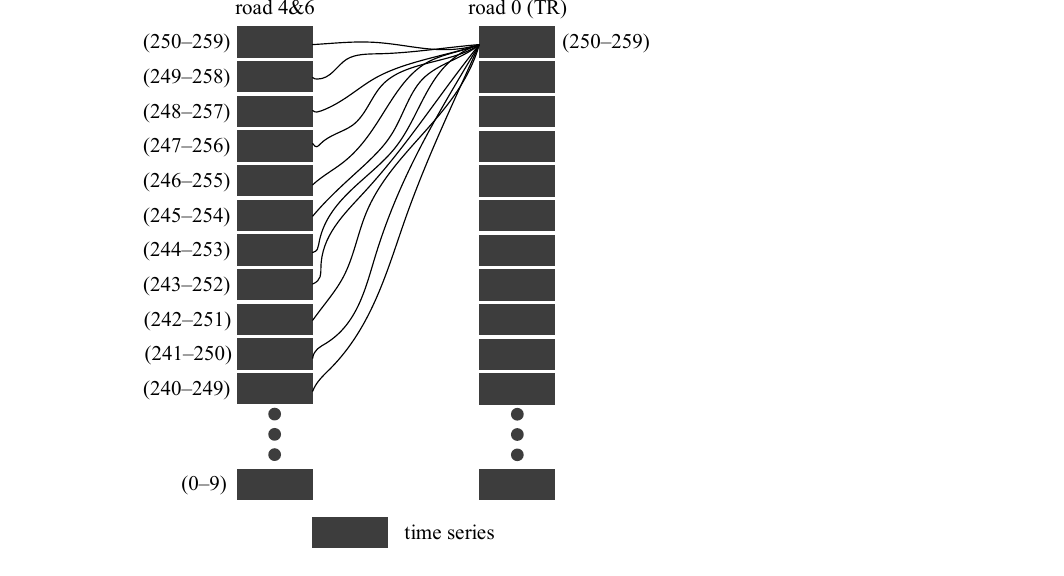
Figure 14. Schematic diagram of the time series between roads participating in the STC calculation and target roads. Table 3. Flow ratio (%) of roads 4 and 6 to road 2.